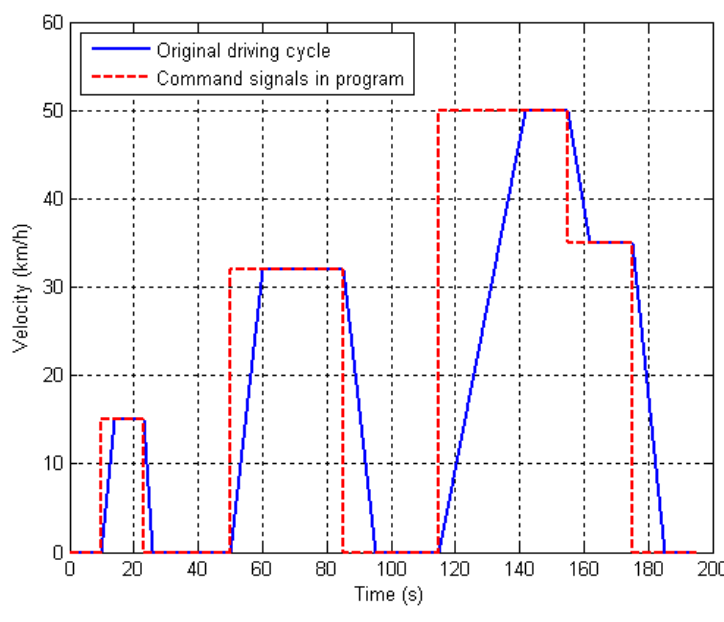
Figure 7. The ECE-40 driving cycle.